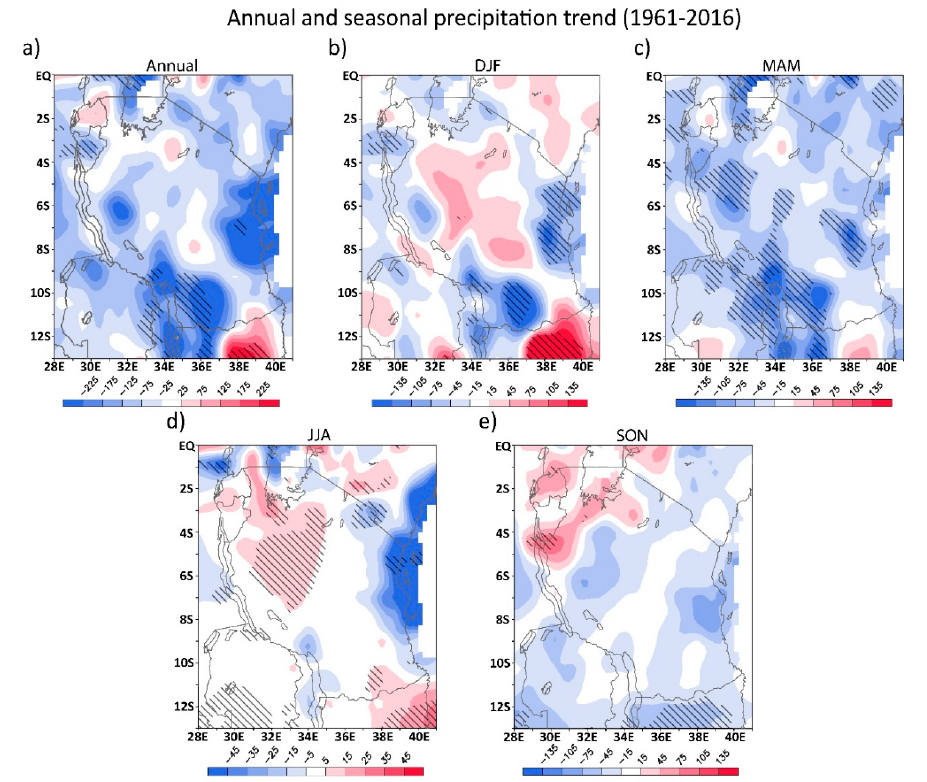
Figure 4. Annual precipitation trend (slope*total number of years) in Tanzania calculated from 1961–2016 Global Precipitation Climatology Centre (GPCC) observations. Precipitation trend are plotted during different season with ( a ) annual precipitation trend, ( b ) Dec–Feb precipitation trend, ( c ) Mar–May precipitation trend, ( d ) Jun–Aug precipitation trend, and ( e ) Sep–Nov precipitation trend. Hatched areas indicate significant values with confidence level > 90%. Precipitation is in